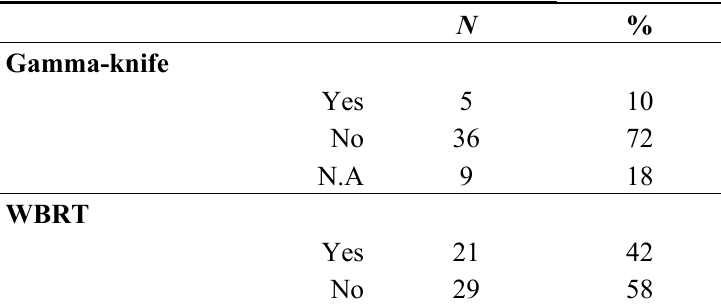
Table 3. Post-neurosurgical treatments. N